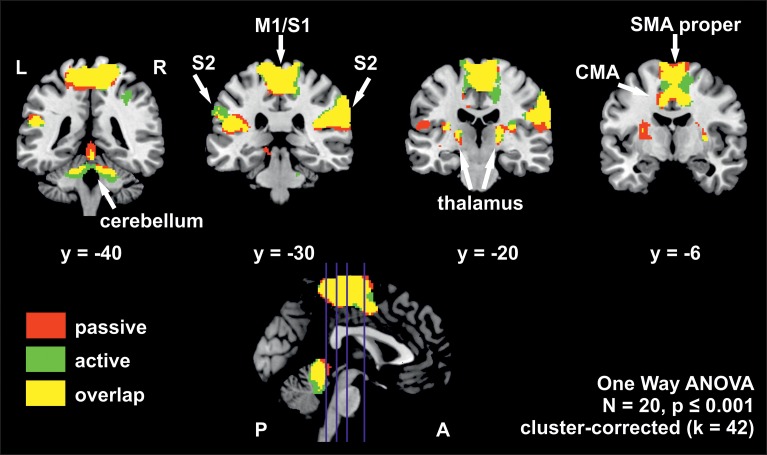
Overlay of BOLD-signal during active (green) and passive (red) stepping reveals robust activations in an extended sensorimotor network. Overlapping activations in yellow. The positions of the coronal slices are indicated by the blue lines in the sagittal slice at the bottom. Estimated β-weights and percent signal changes from the ROI-analysis are provided in Table 4. M1/S1, primary sensorimotor cortex; S2, secondary sensory cortex; CMA, cingulate motor area; SMA proper, supplementary motor area proper; L, left hemisphere; R, right hemisphere; P, posterior; A, anterior.